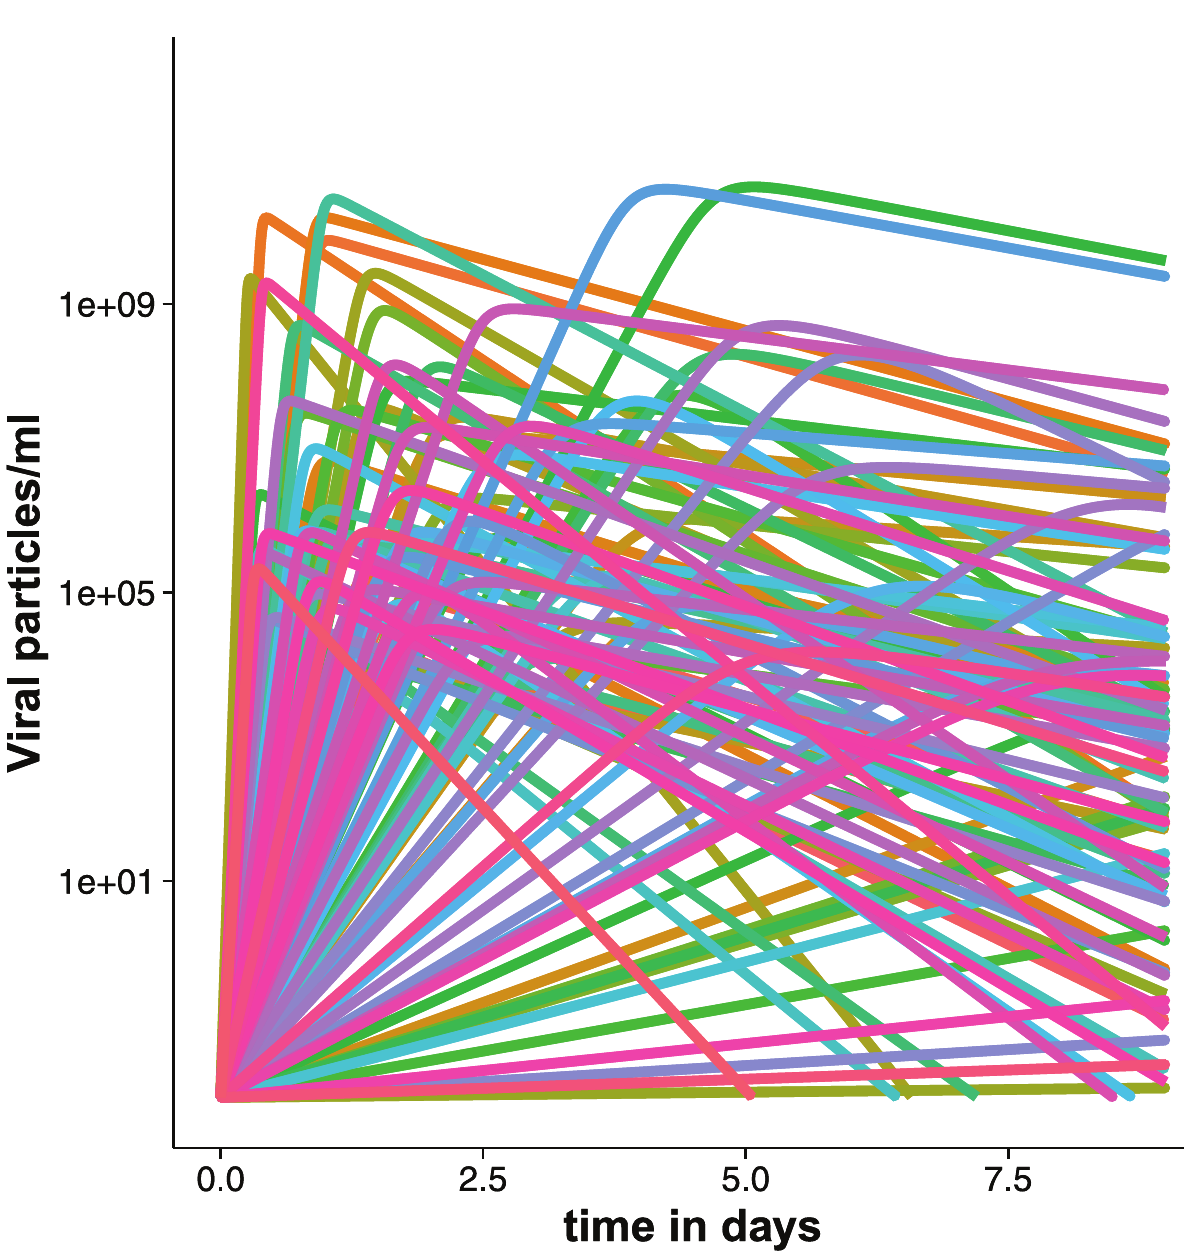
Fig 1. Viral load curves over time of 50 (a) and 100 (b) patients. If there are less curves than simulated patients, the infection did not take off in the remaining number of patients ( R 0 < 1) (curve is a flat line across the x-axis). x-axis: time in days, y-axis: viral load in particles per